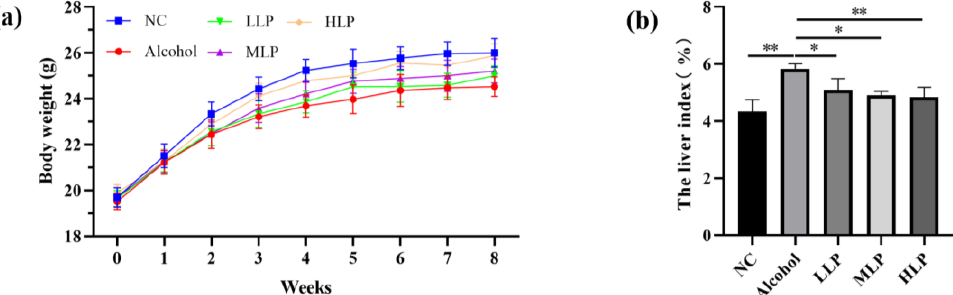
Figure 2. Effects of L. plantarum J26 on body weight and liver index in the mice. ( a ): body weight; ( b ): liver index. NC, normal control; LLP, low-dose L. plantarum J26; MLP, medium-dose L. plantarum J26; HLP, high-dose L. plantarum J26. The data were analyzed with a one-way ANOVA and expressed as means ± SD ( n = 10). * p < 0.05, ** p < 0.01 compared with the Alcohol group.